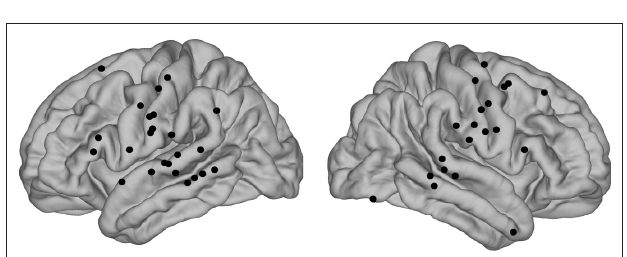
Figure 4 | example responses from an individual subject. Triplet-locked evoked potentials from an 8 x 8 electrode array over the right hemisphere whose configuration on the individual’s cortical surface is shown at right. Different frequency-separation conditions are represented by different color waveforms as shown in the lower right panel. Significant correlations between